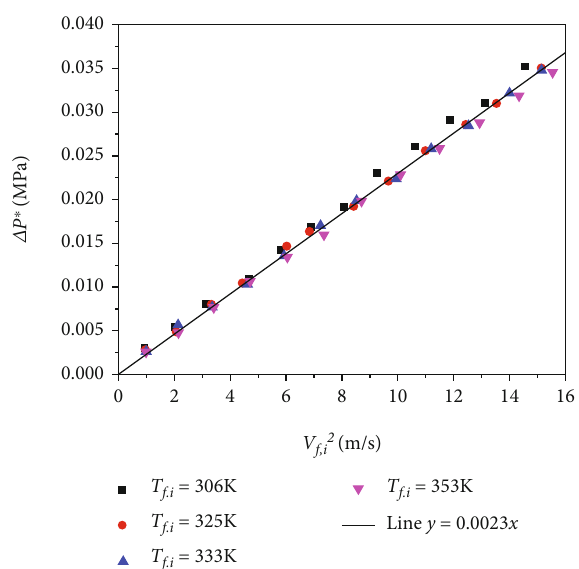
Figure 13: Total pressure loss variation with inlet velocity square in main fuel